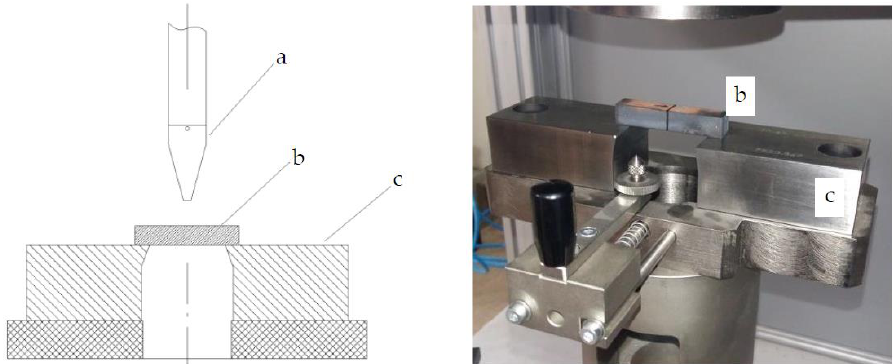
Figure 3. Impact test setup: ( a ) impactor; ( b ) un-notched test specimen; ( c ) Charpy fixture.